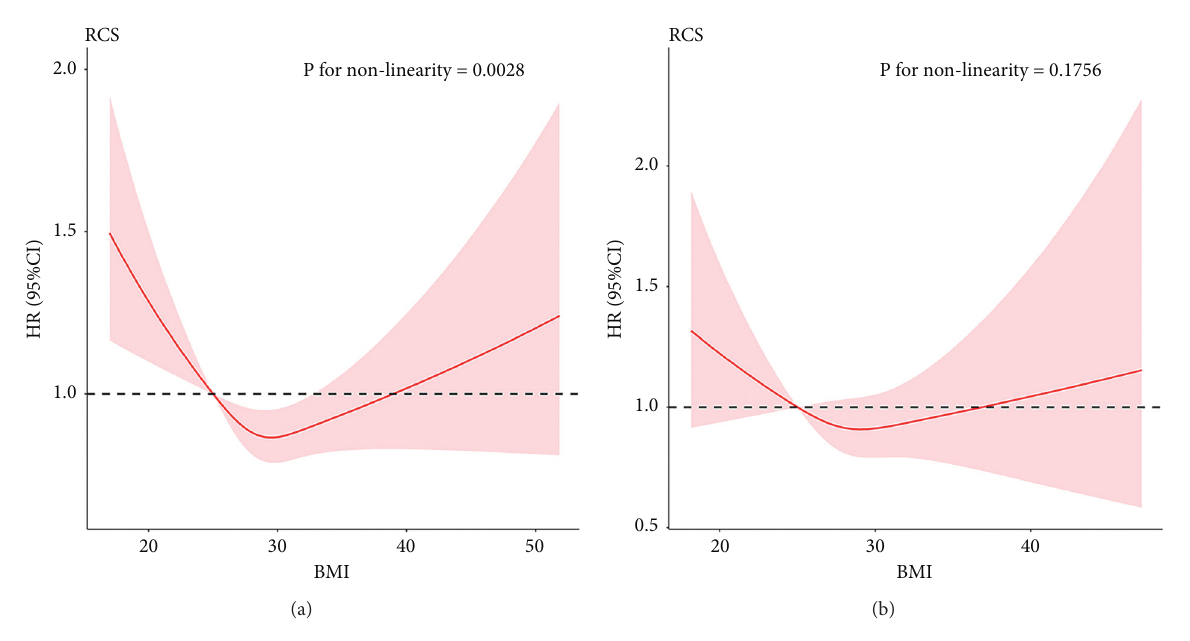
Figure 3: Dose-response curves for BMI and all-cause mortality of CABG patients (a) and PCI patients